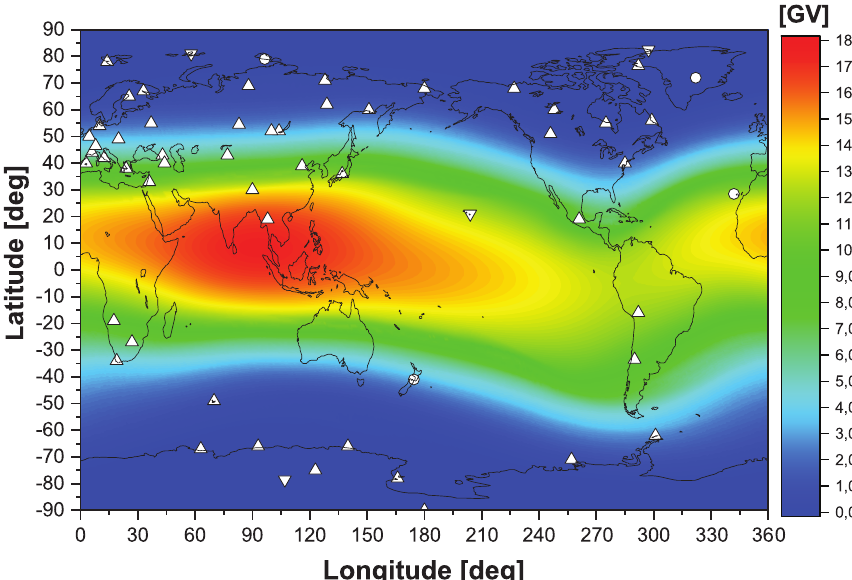
Fig. 1. Present status of the global neutron monitor network and proposition for further extension. The up triangles correspond to presently operational stations. The down triangles correspond to previously existed stations. Circles correspond to the new stations proposed here. The color diagram depicts rigidity cut-off map computed in quiet magnetospheric conditions employing the IGRF model corresponding to epoch 2015 (Thébault et al.,